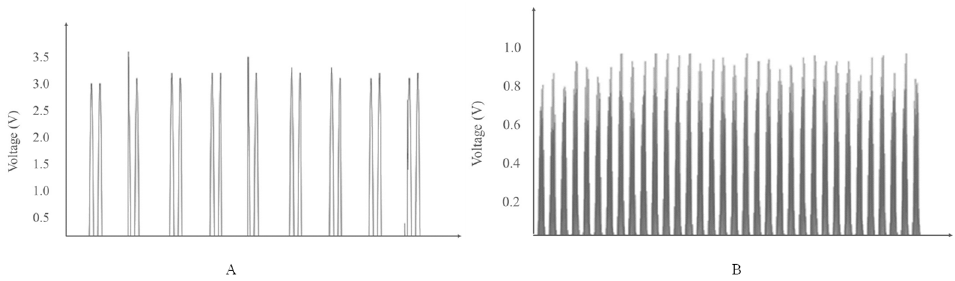
Figure 11. Dynamic Voltage Output of two different phones with two different applied vibration amounts in ( A ) and ( B ), respectively.